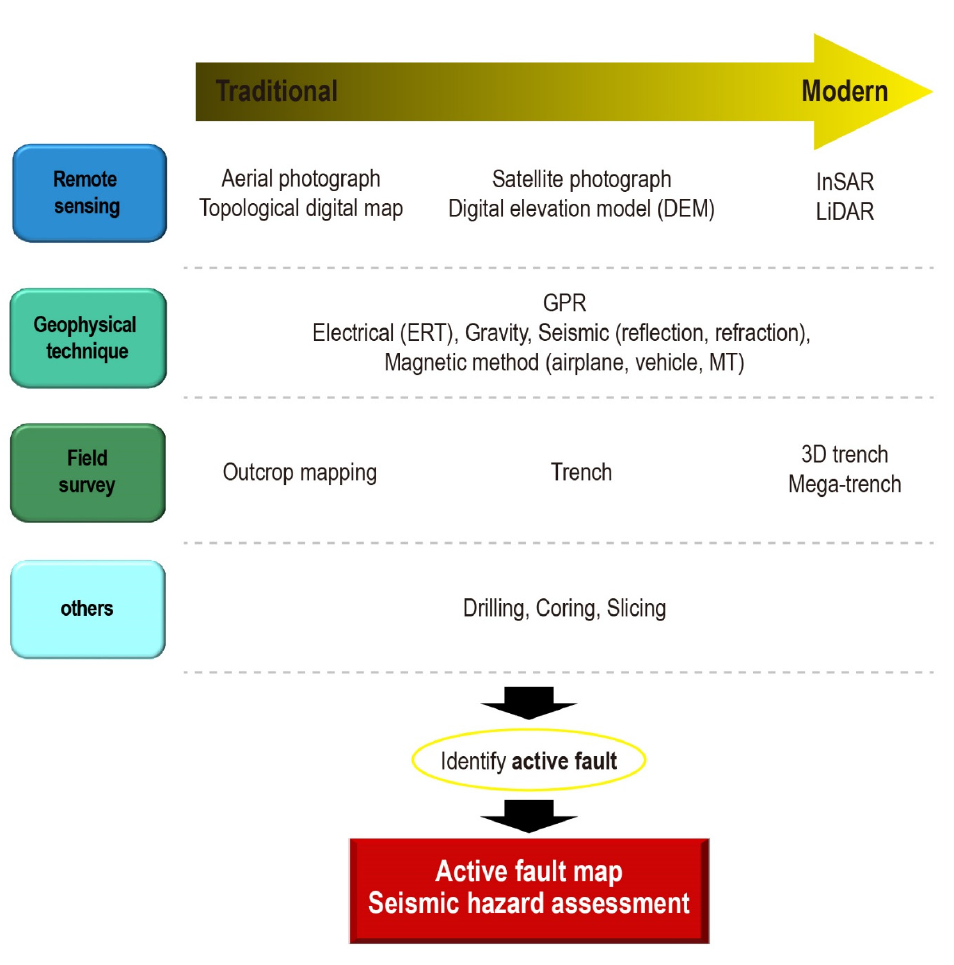
Figure 1. General methods used in terrestrial paleoseismic investigations. Technological innovations have led to the development of advanced survey techniques, which give the option to select various survey techniques depending on the site-specific condition. Nevertheless, traditional techniques are still needed and used now and can be complemented by modern